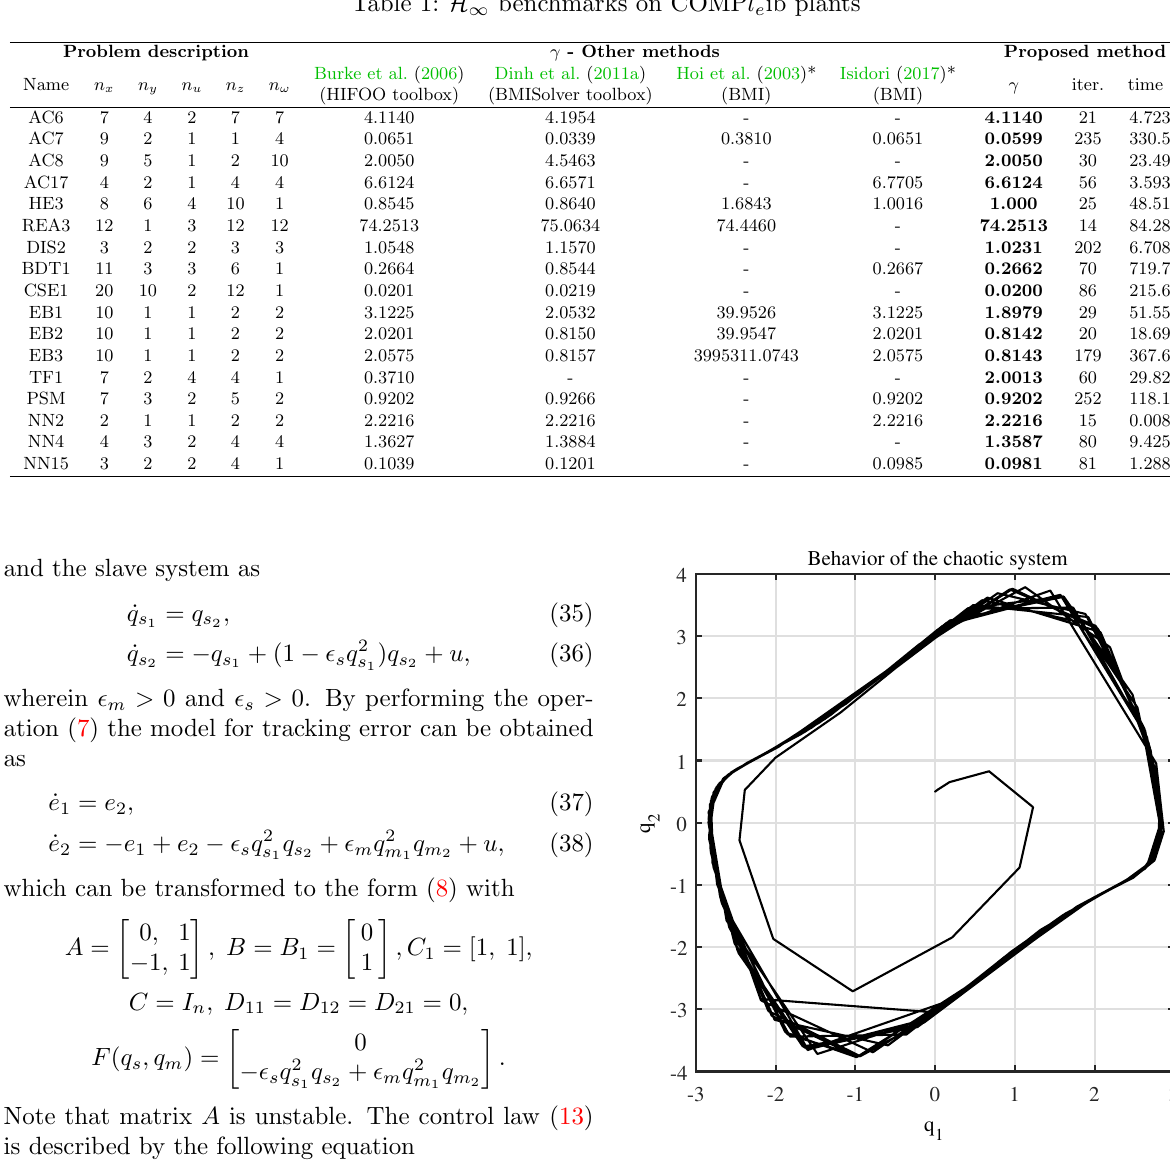
Table 1: H ∞ benchmarks on COMP l e ib plants